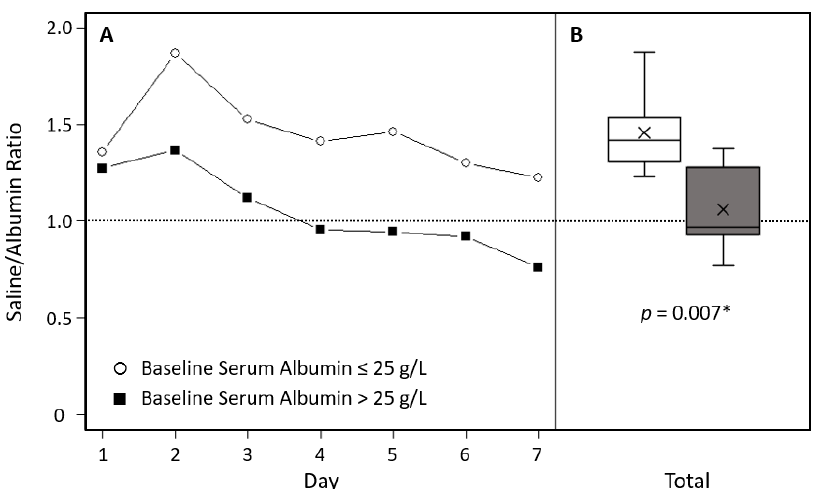
Figure 4. Ratios of the volume of albumin to the volume of saline by baseline serum albumin concentration of patients using data of the ‘Saline versus Albumin Fluid Evaluation’ (SAFE) Study. Data published in Ref. [41] were analyzed. ( A ) Mean saline to albumin ratios on days 1 to 7 in the two patient groups by serum albumin levels. ( B ) Box blots of mean saline to albumin ratios of days 1–7 in patients with baseline serum albumin concentration of 25 g/L or less and patients with serum albumin of more than 25 g/L. * Mann – Whitney U test.